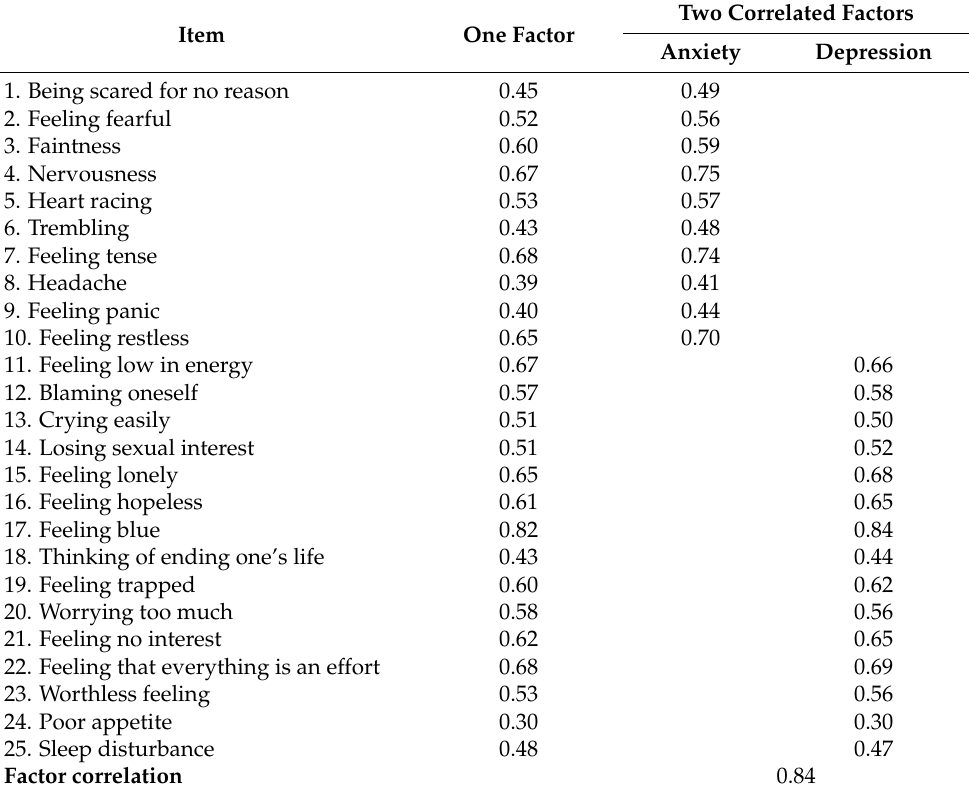
Table 4. Confirmatory factorial analysis: factor loading values and correlation between two depres- sion and anxiety